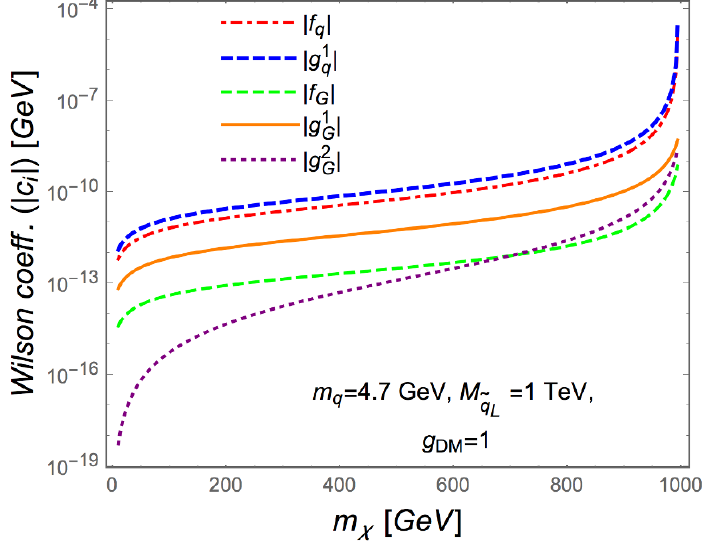
Figure 3 . Absolute values of the bottom quark and gluon Wilson coe(cid:14)cients (as indicated, in appropriate powers of GeV for each) as a function of the dark matter mass, for M ~ q = 1 TeV, m q = m b = 4 : 2 GeV and g DM =